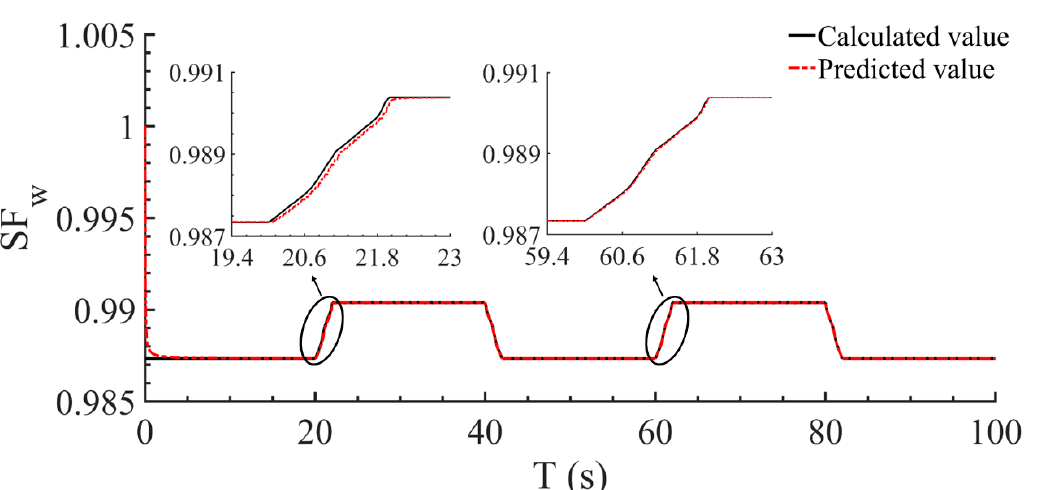
Figure 15. Prediction results of the